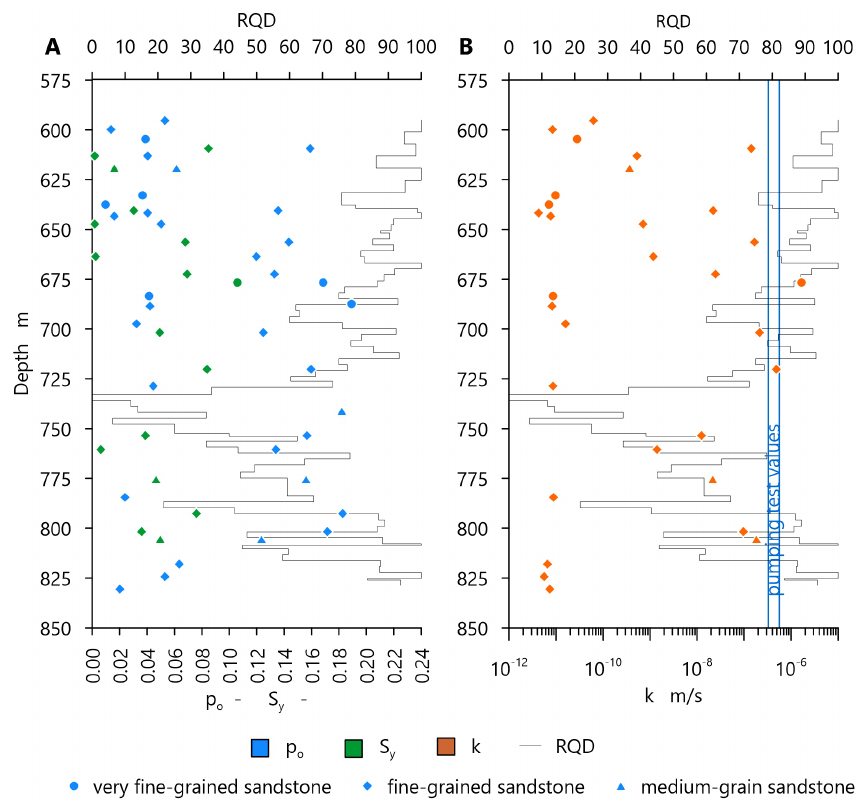
Figure 15. Distribution of p o , S y ( A ) and k ( B ) in the vertical profile.